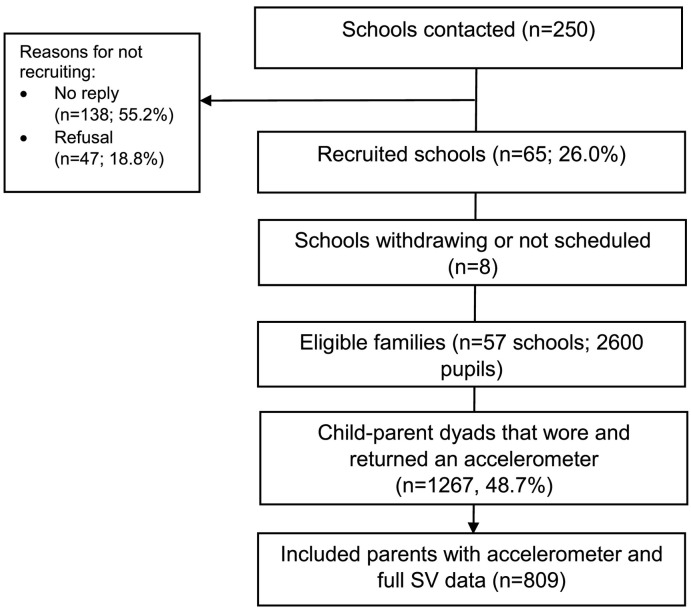
Study flow of participants.